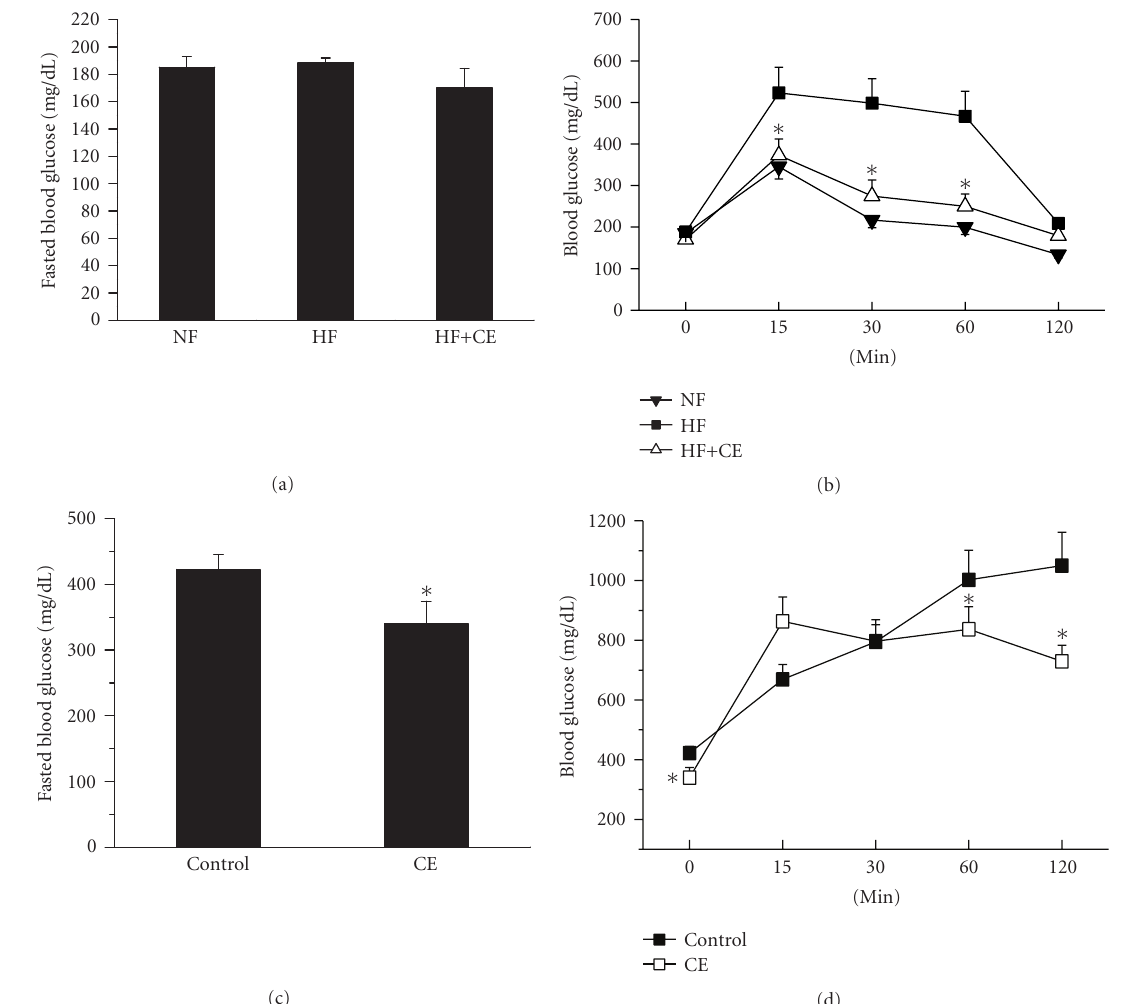
Figure 1: CE reduced the fasted blood glucose level and improved glucose tolerance in DIO and db/db mice. Mice were administered vehicle alone, or CE (equivalent to 400 mg cinnamon powder kg • day • ) for 3 weeks (DIO) or 2 weeks ( db/db ). The blood glucose levels were measured in tail vein and the basal glucose levels were shown at 0 minute. (a) DIO C57BL/6J mice were fasted overnight and glucose levels were measured at 9:00 am at the end treatment. NF: normal food fed mice; HF: high-fat food-induced mice; CE: cinnamon water extract; (b) fasted DIO mice were intraperitoneally injected with 2 g glucose • kg − body weight and glucose tolerance determined at the time indicated; (c) db/db Mice were fasted for 6 hours and the fasted blood glucose was measured. CONT: vehicle; (d) glucose tolerance was determined following 2g glucose • kg − 1 body weight intraperitoneal injection in db/db mice. The data are presented as mean ± SE, n = 5 for each group. (b) ∗ P < . 05 versus HF group or (d) vehicle control (cont).